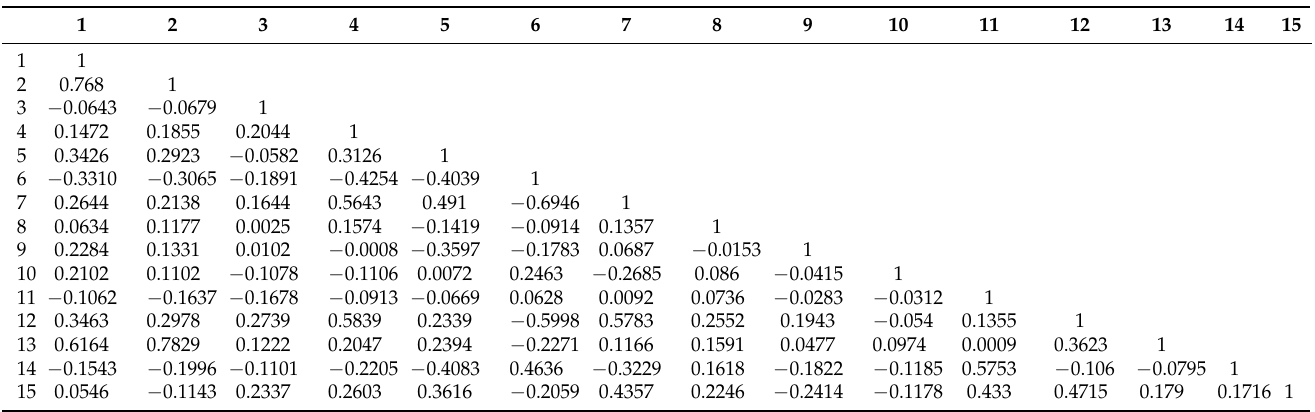
Table 2. The correlation